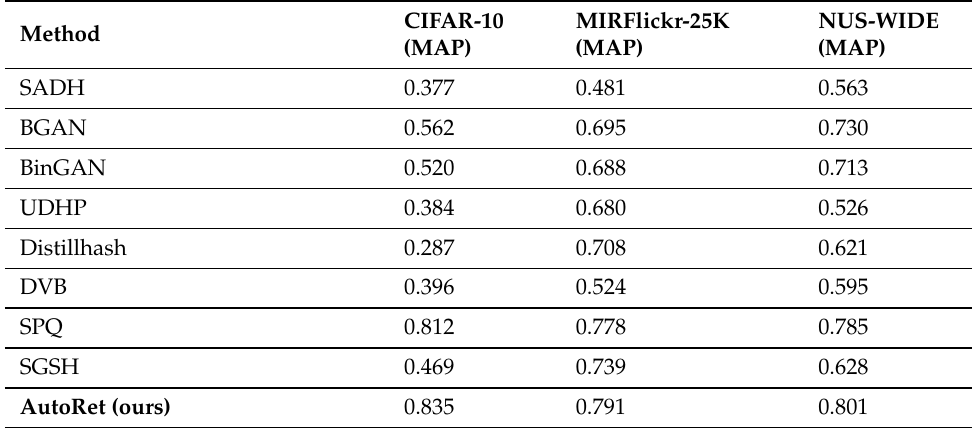
Table 3. A comparison of different image retrieval